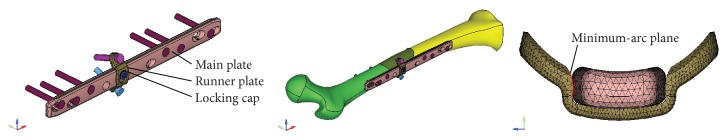
Runner plate integrates with the main plate through the locking female screws. Newly designed assembly locking compression plate (NALCP) fixated in long-bone comminuted fractures. Minimum-arc plane between the inner medial surface of the runner plate and the lateral surface of the main plate.